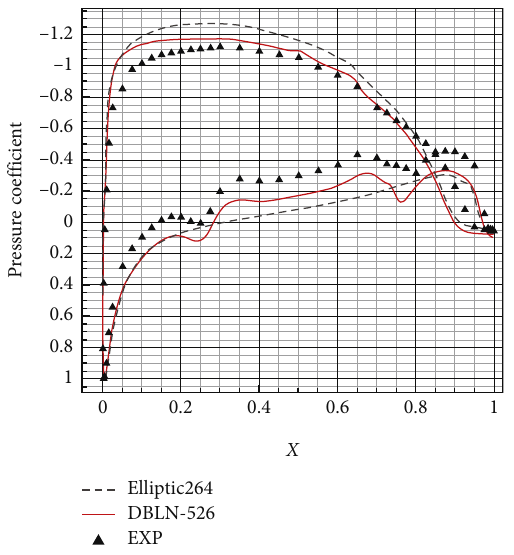
Figure 16: Lower surface transition position ( Re = 1 : 4 E 6